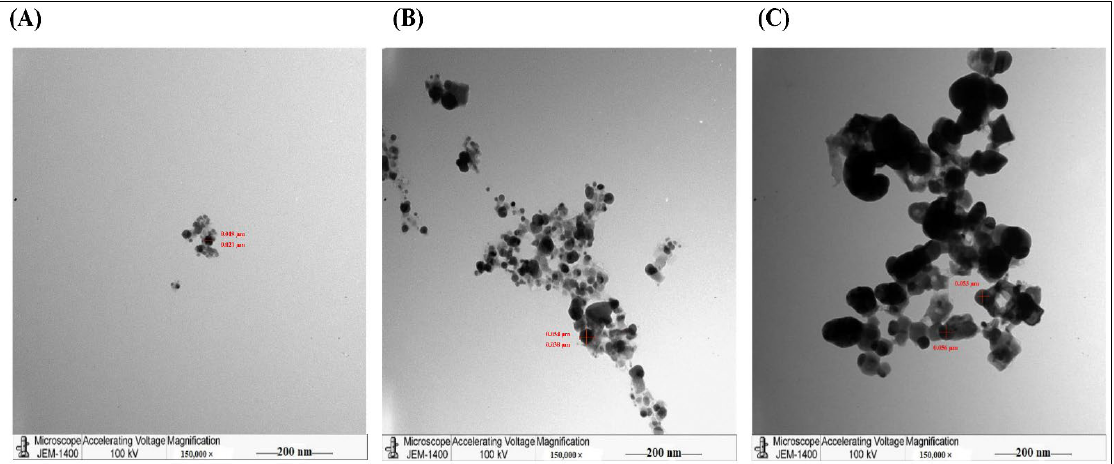
Figure 2. TEM images of the purified AgNPs. It was stained by UA/ LC and examined by the JEM-1011 transmission electron microscope. ( A ) AgNO 3 , ( B ) Aqueous of extract Phoenix dactylifera L. leaves, ( C ) AgNPs of Phoenix dactylifera L. leaves aqueous extract.